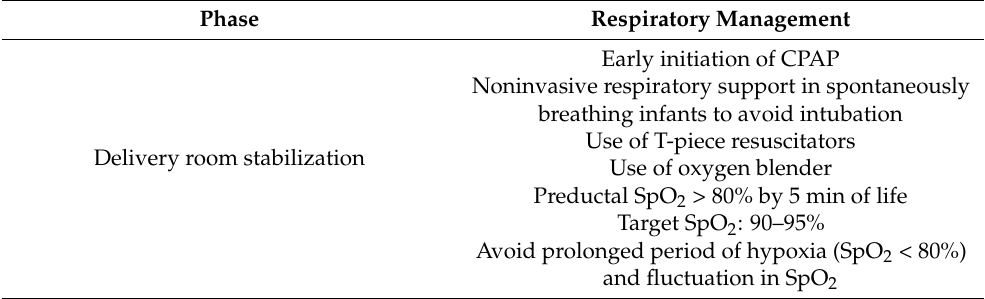
Table 3. Summary of current evidence for respiratory management of preterm